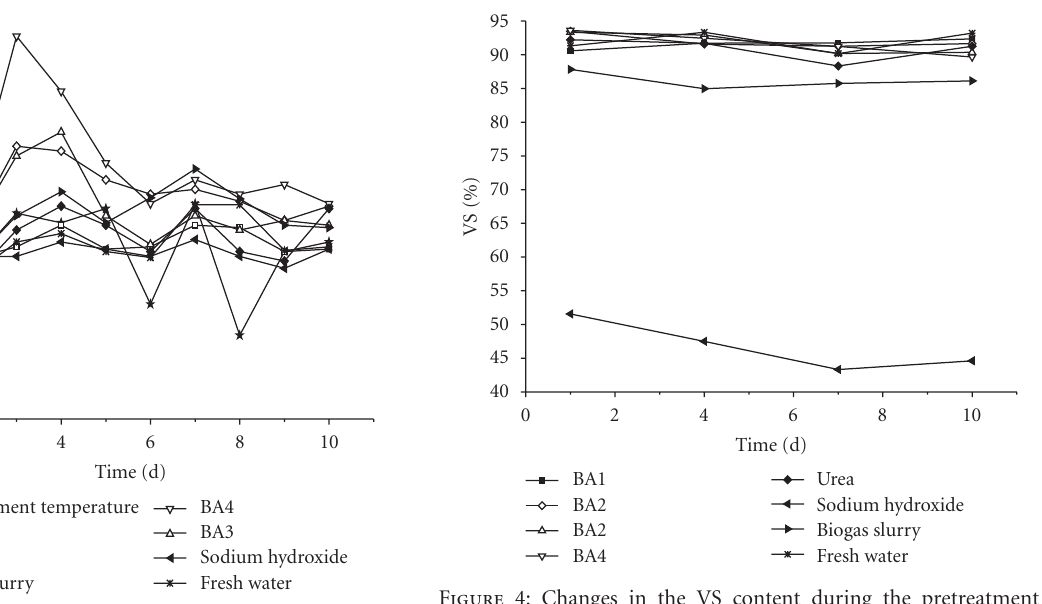
Figure 4: Changes in the VS content during the pretreatment